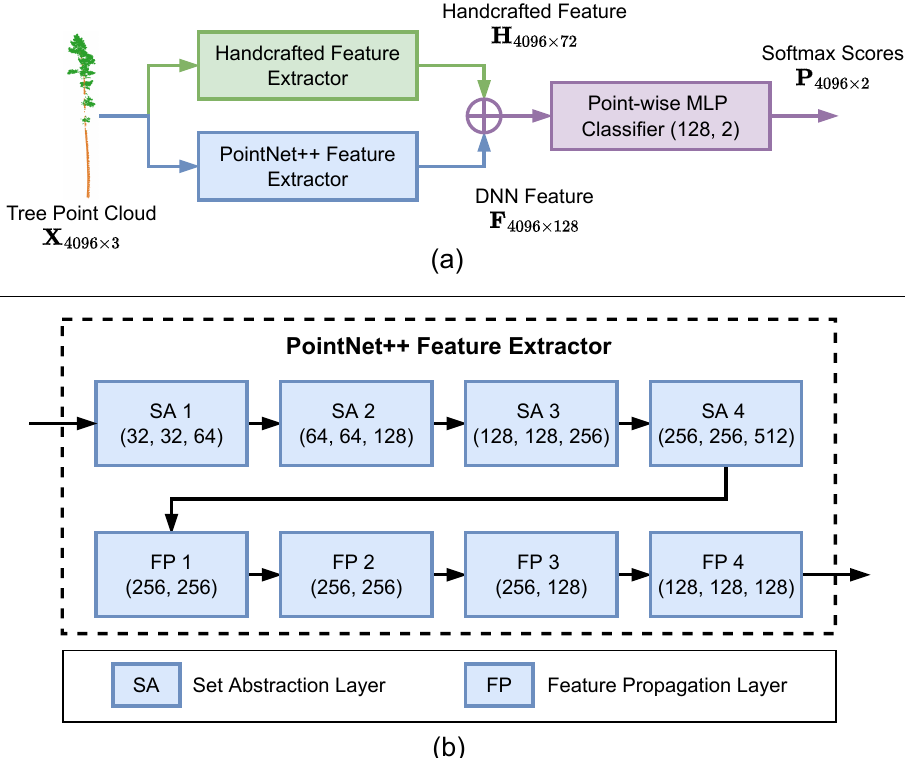
Figure 3. Our backbone model for point cloud semantic segmentation in which we integrate our handcrafted feature into the PointNet++ model. ( a ) Overview of our backbone model, where we use a point cloud with 4096 points as an example. We first use the handcrafted and PointNet++ feature extractors to produce two feature matrices H and F , respectively, where each feature matrix is a set of point-wise features across all points. Then we merge the features H and F through the matrix concatenation operator along the feature dimension, which is denoted as the ‘ ⊕ ’ symbol in the figure. We feed the merged point-wise features H ⊕ F to a point-wise MLP classifier with two fully-connected layers (128 and 2 channels, respectively) and a softmax layer to produce the segmentation predictions P for each point. ( b ) Details of the PointNet++ feature extractor. We use 4 set abstraction (SA) layers and 4 feature propagation (FP) layers, and we specify the number of channels we use for the point-wise MLP contained in each SA and FP